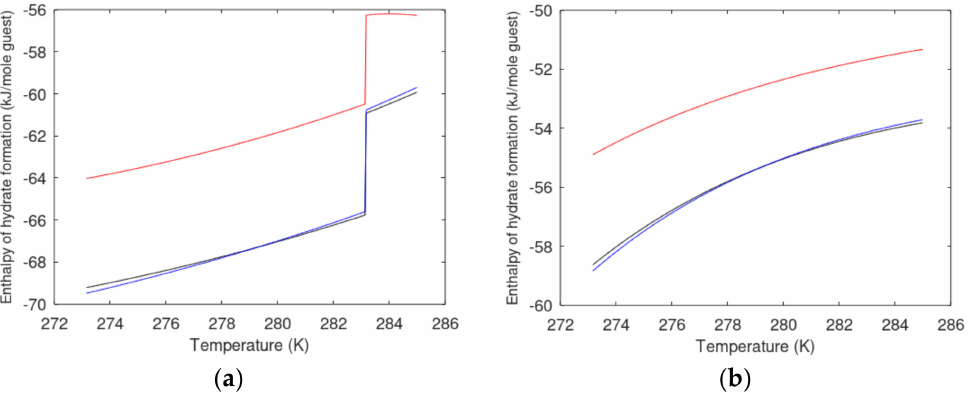
Figure 9. ( a ) Enthalpy of hydrate formation along pressure temperature stability limits for CO 2 hydrate. ( b ) Enthalpy of hydrate formation along pressure temperature stability limits for CH 4